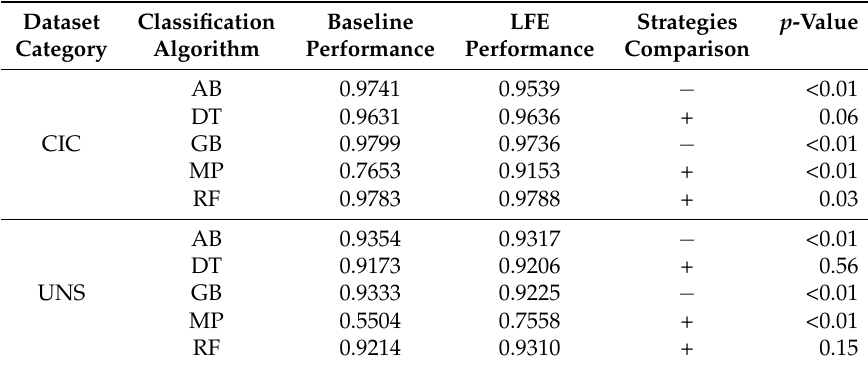
Table 13. LFE strategy performance comparison—additional datasets.